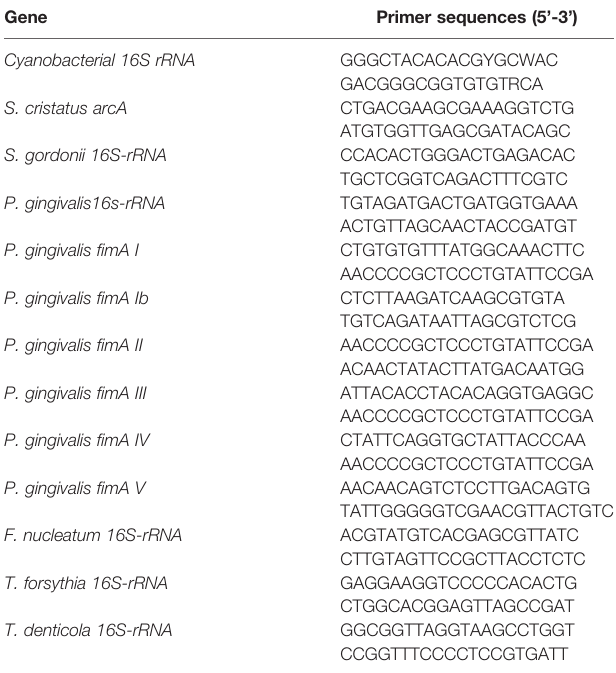
TABLE 1 | Primers used in this study.